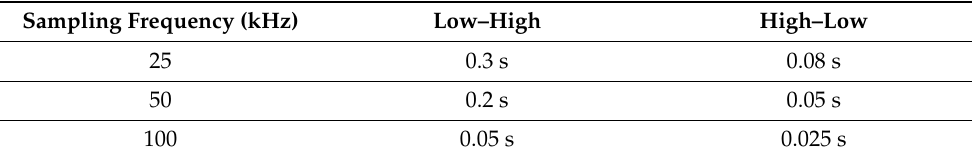
Table 4. Speed response corresponding to the change in the reference